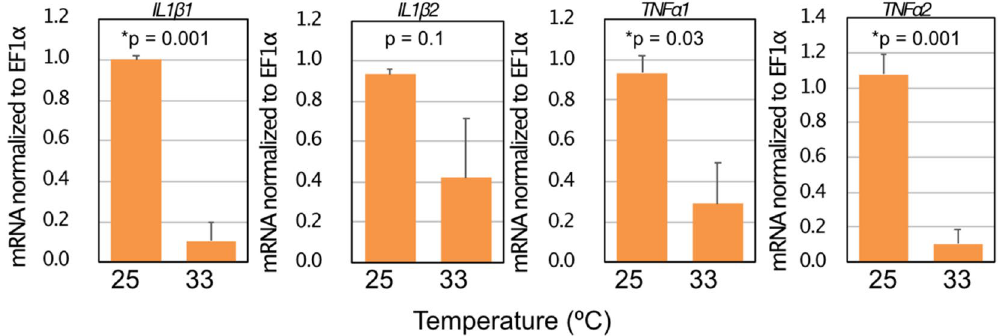
Figure 5. High temperature suppresses the expression level of pro-inflammatory cytokines in the eye-sac cells. Levels of mRNA for IL1β1, IL1β2, TNFα1 and TNFα2 were measured by qRT-PCR. Results from the increased- ◦ temperature (33 C, n = 3) condition and the normal temperature condition (25 figure (values were normalized to EF1α). P values from Student’s t-test are shown in the figure. The asterisks represent statistically significant differences between temperatures (significance levels were corrected by Benjamini–Hochberg procedure).